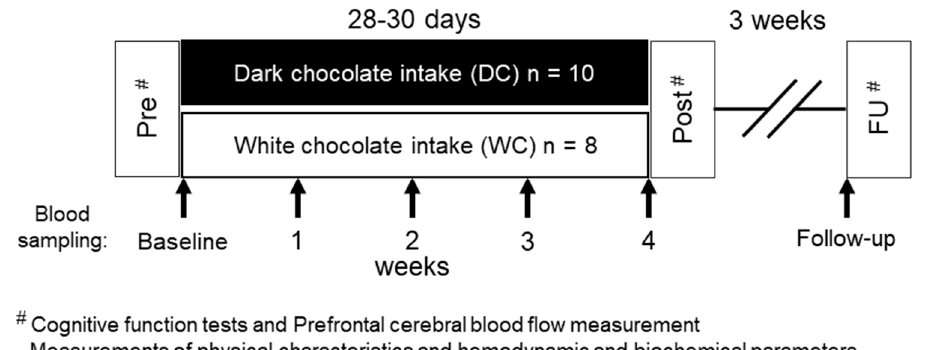
Figure 1. Experiment schedules. Subjects took chocolate daily for 30 days (Chocolate-intake intervention). The subjects’ physical characteristics, cognitive function test, and prefrontal cerebral blood flow (PFCBF) were recorded pre-(Pre) and postintervention (Post) and at a follow-up (FU) visit, 3 weeks after the end of the intervention. Blood was sampled before chocolate intake (baseline), during the chocolate intake intervention (1, 2, 3, and 4 weeks), and 3 weeks after the end of the intervention (FU).